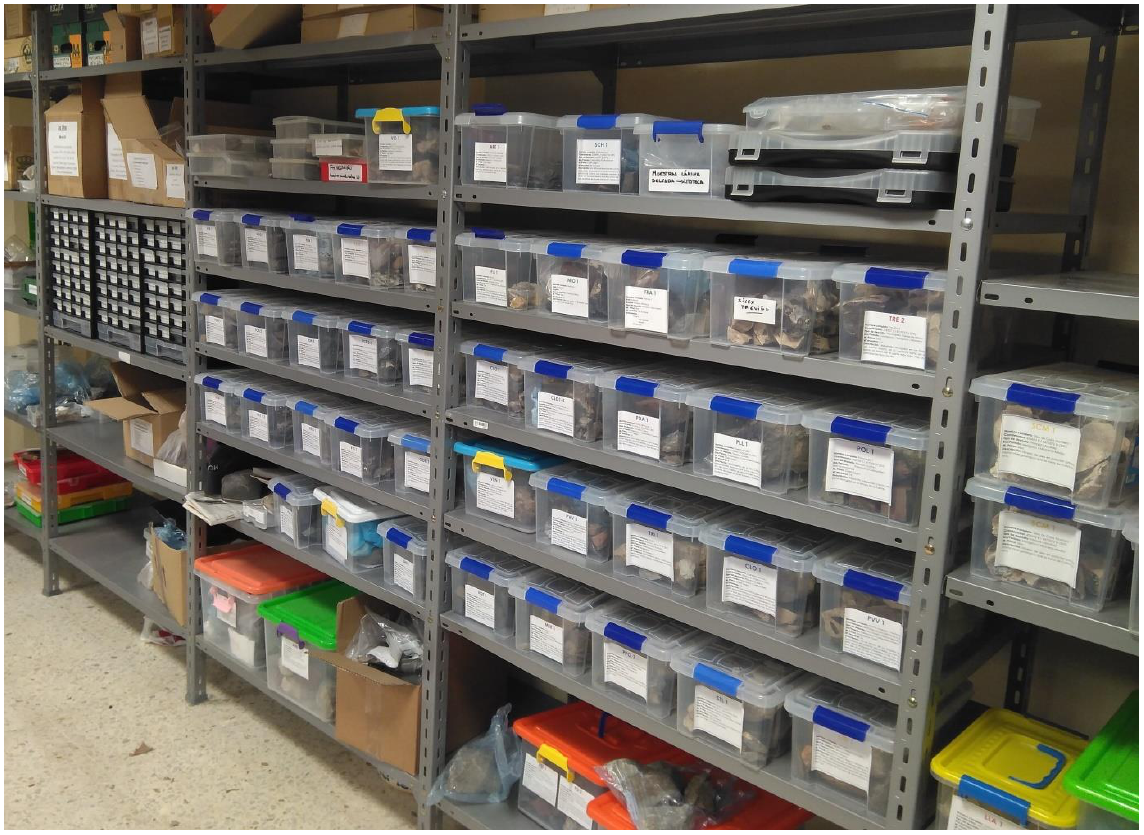
Figure 1. General view of the LegioLit in the Prehistory Laboratory at University of